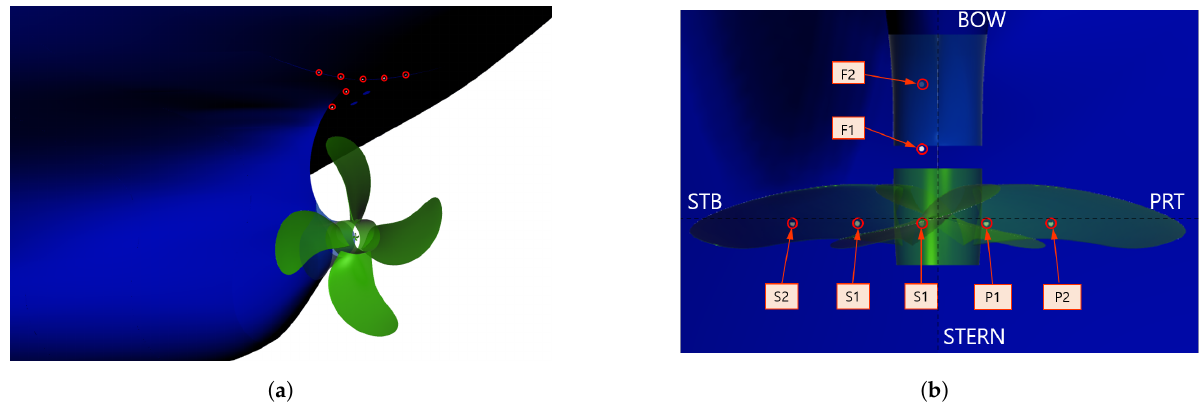
Figure 18. Positions of the pressure sensors (bottom view): ( a ) overall and ( b ) relative to the propeller.